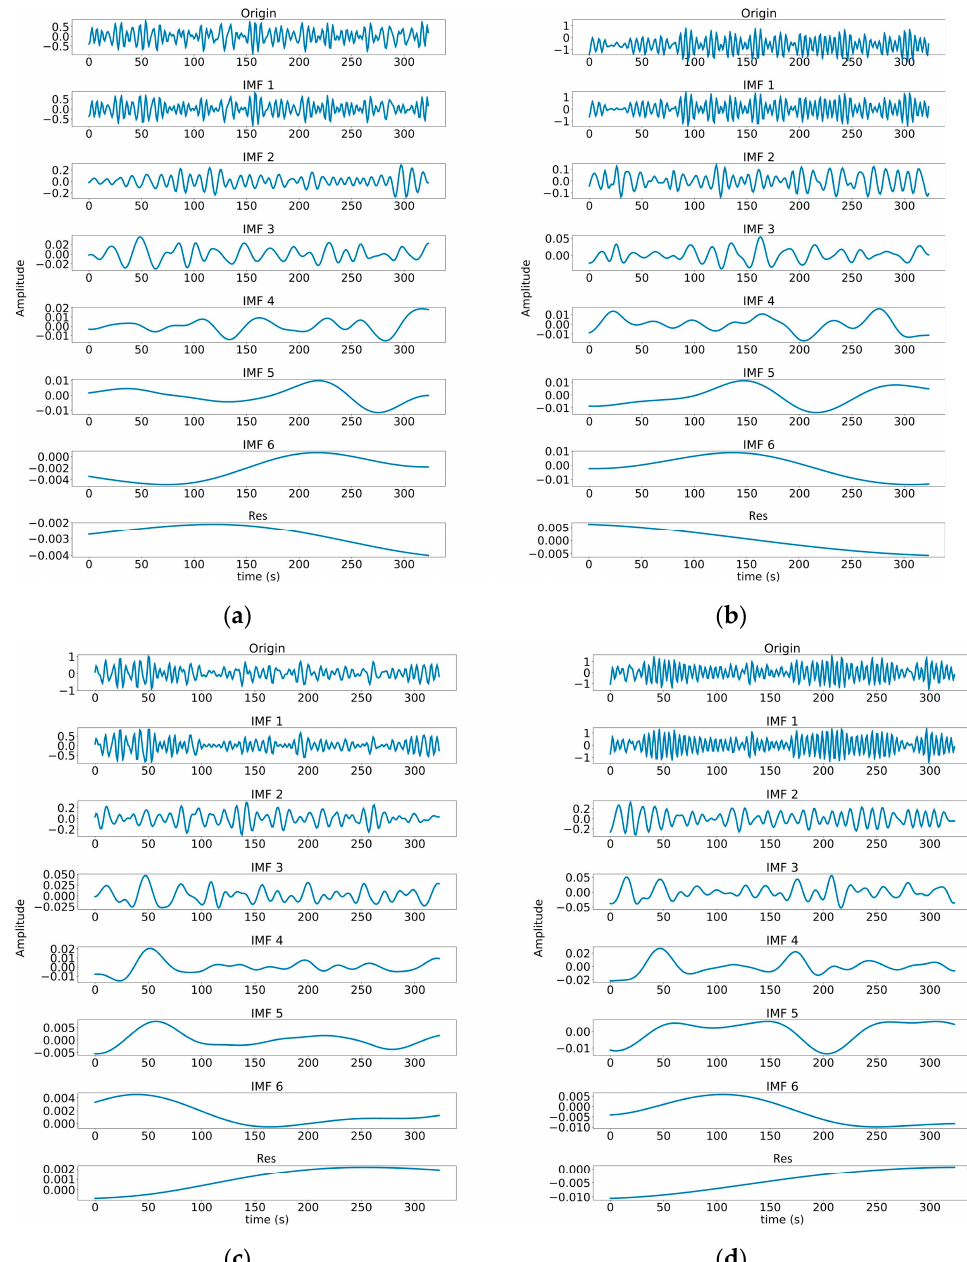
Figure 5. Results of EEMD decomposition of the accelerometer. ( a ) C1; ( b ) C2; ( c ) C3; ( d ) C4.